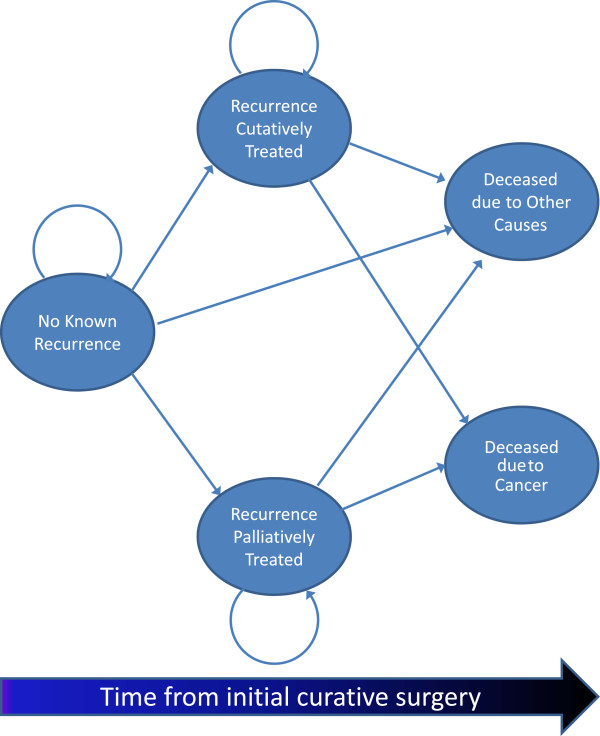
Possible state transitions in the surveillance and re-treatment submodel. An individual-based Markov submodel simulates the follow-up testing which may lead to detection of asymptomatic recurrence, and the treatment which may occur after recurrence diagnosis. The arrows represent possible state transitions which could occur at each three-month time step. Each patient begins the model in the “No known recurrence” state wherein they undergo surveillance testing according to a sepcified schedule. If a true recurrence is discovered, the patient will proceed to one of the two states: “Recurrence curatively treated” or “Recurrence palliatively treated”, depending on whether the current model cycle occurs before or after Ui (Ui is assigned as a continuous value based on the disease progression submodel). Patients in the “Recurrence curatively treated” state continue to undergo surveillance testing after treatment. During each cycle, individuals may move to the “Dead due to other causes” state from any other living state based on a background transition probability of mortality from other causes. Additional file 1: Figure S1 provides a more detailed depiction of the contingencies which drive state transitions in the surveillance and re-treatment submodel.